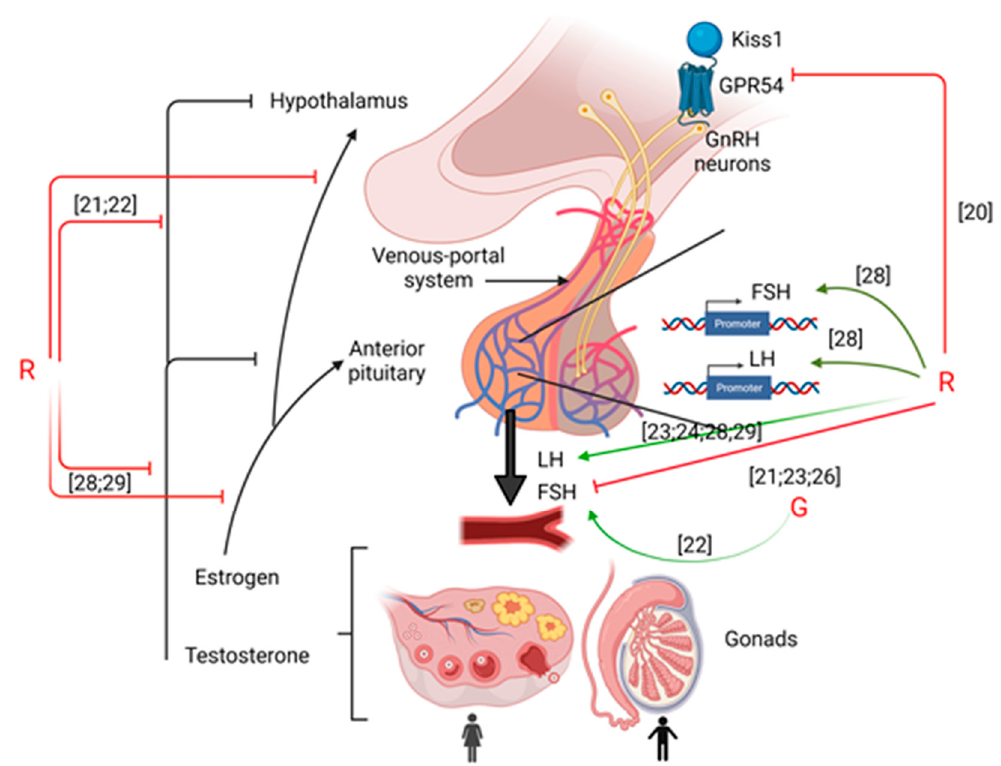
Figure 1. Summary of the effects of G or R on hypothalamus-pituitary-gonads axis. Green arrows mean activation and red arrows mean inhibition. Numbering in brackets indicates references.